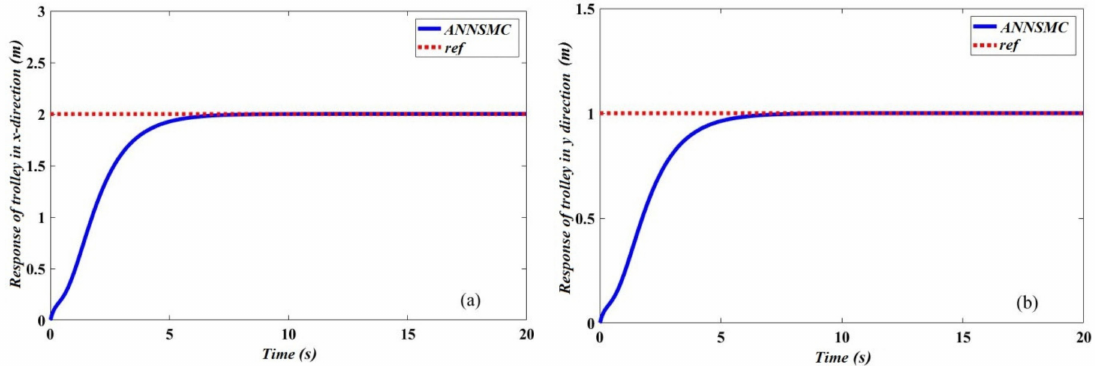
Figure 5. The trolley position when the payload mass is 10 kg.